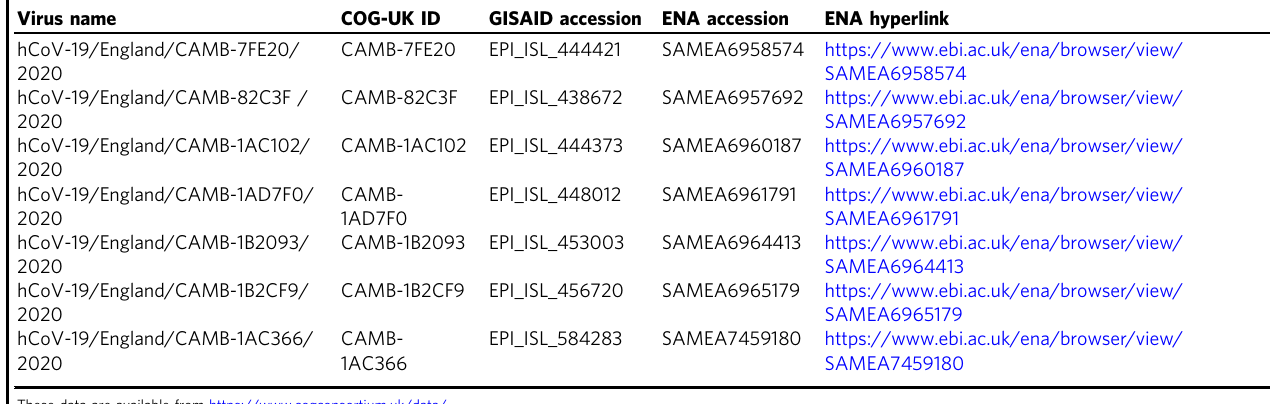
Table 5 Viral sequence accession numbers that were compared to the reference GenBank accession MN908947.3. Virus name